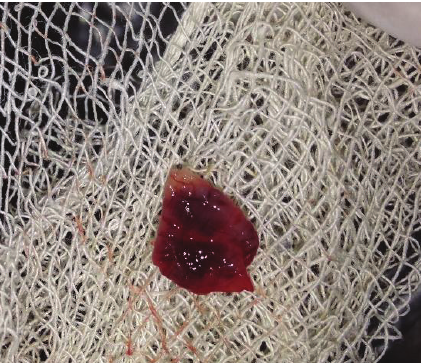
Figure 27: PRF membrane